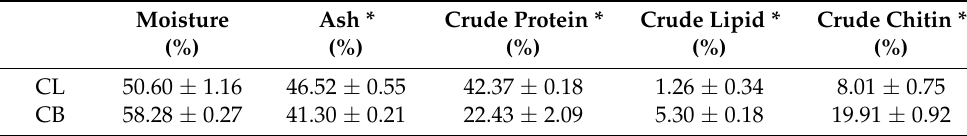
Table 1. Basic components of CLs and CBs from the Chinese mitten crab.